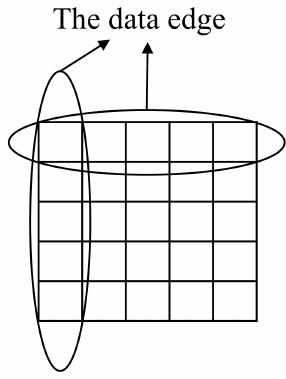
Figure 1. Data edge of 2D signal.